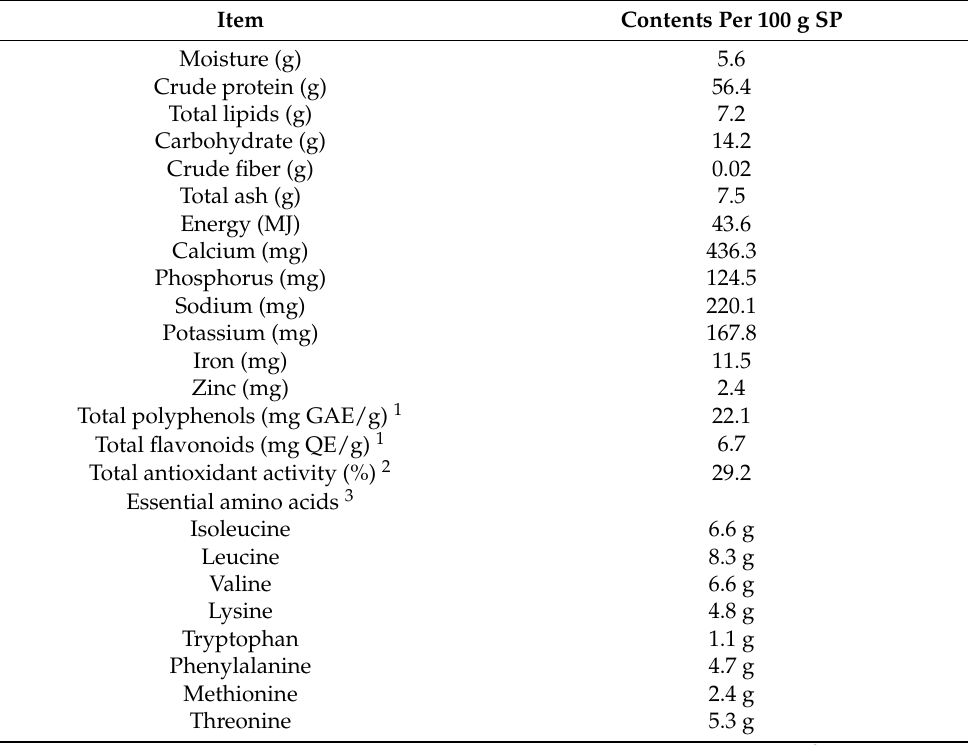
Table 1. The results of Spirulina platensisis (SP) chemical